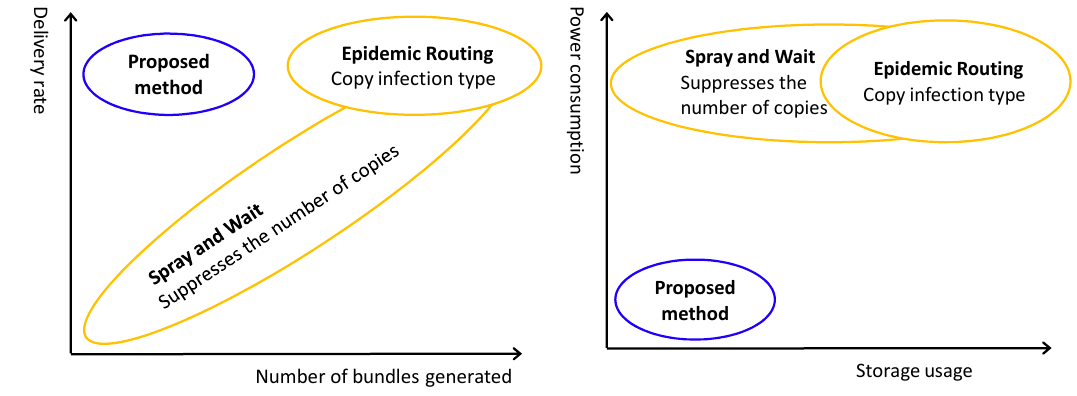
Figure 3. Performance objectives for the protocol used to collect safety confirmation